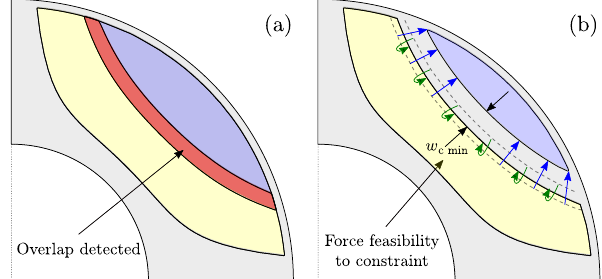
Figure 2. Infeasible geometry ( a ) and forced feasibility ( b ).